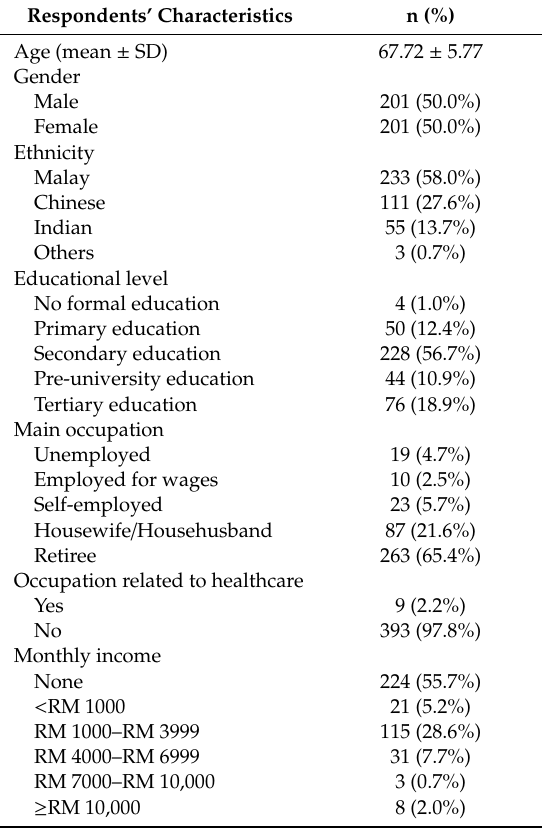
Table 1. Demographic characteristics of respondents (n =